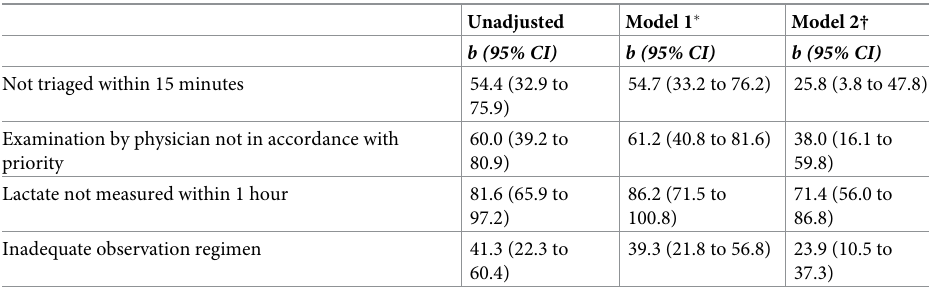
Table 3. Linear regression for factors associated with delay in antibiotic